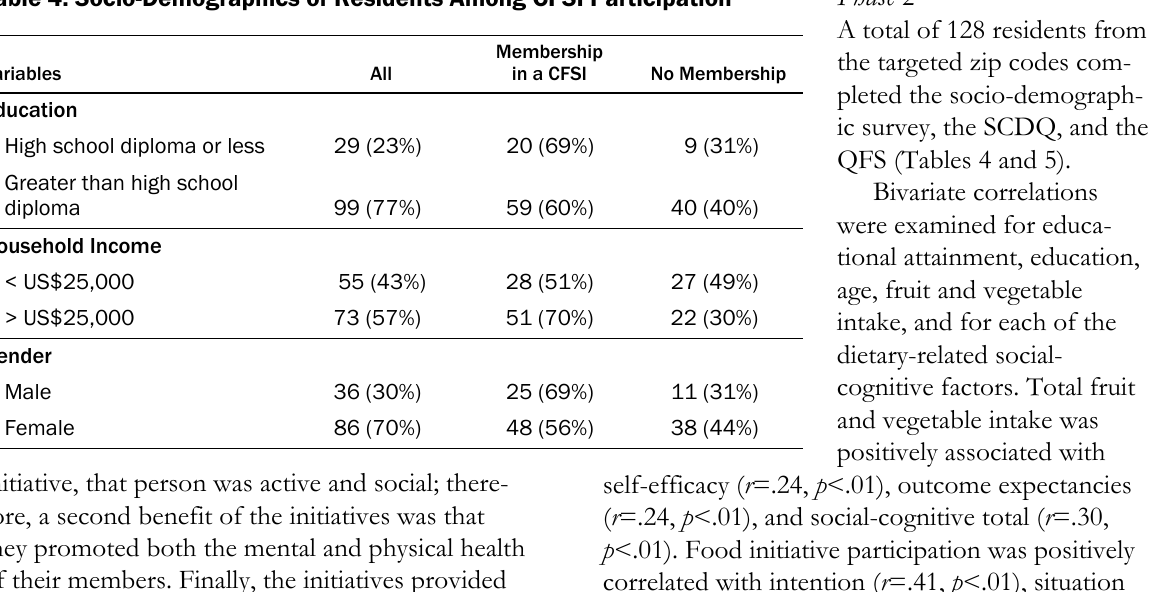
Table 4. Socio-Demographics of Residents Among CFSI Participation